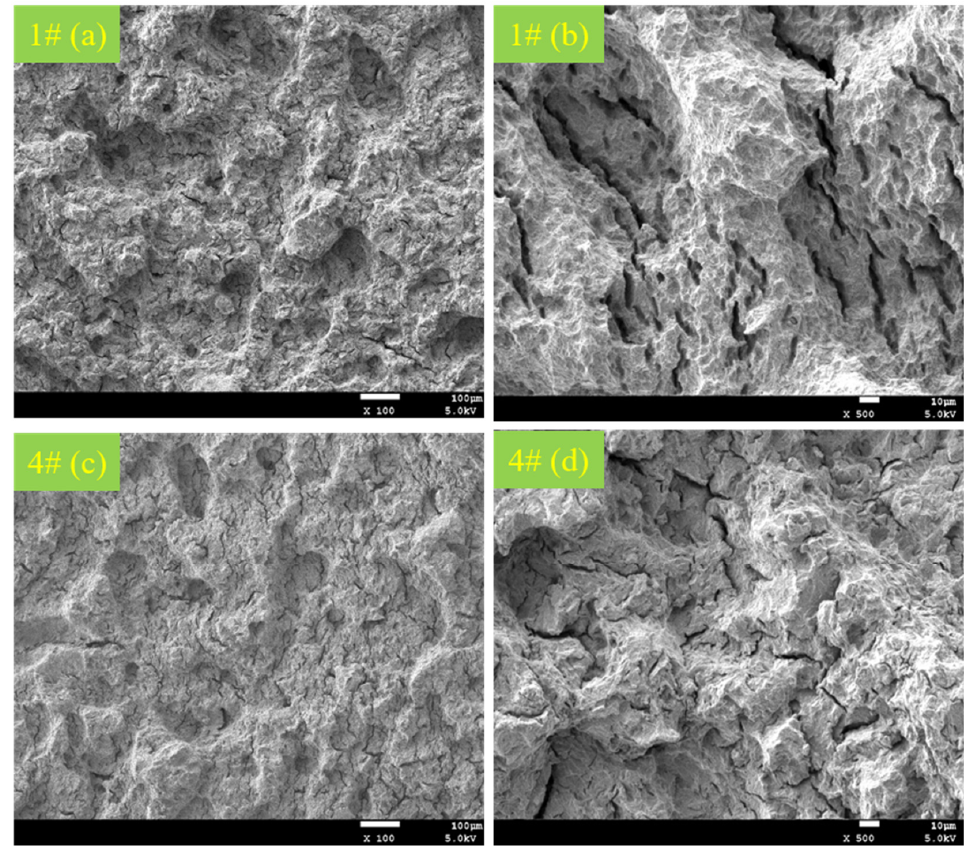
Figure 15. Microstructural morphology of ×100 ( a , c ) and ×500 ( b , d ) fractures after corrosion in sam- ples of C110-1 ( a , b ) and C110-2 ( c , d ). samples of C110-1 ( a , b ) and C110-2 ( c , d